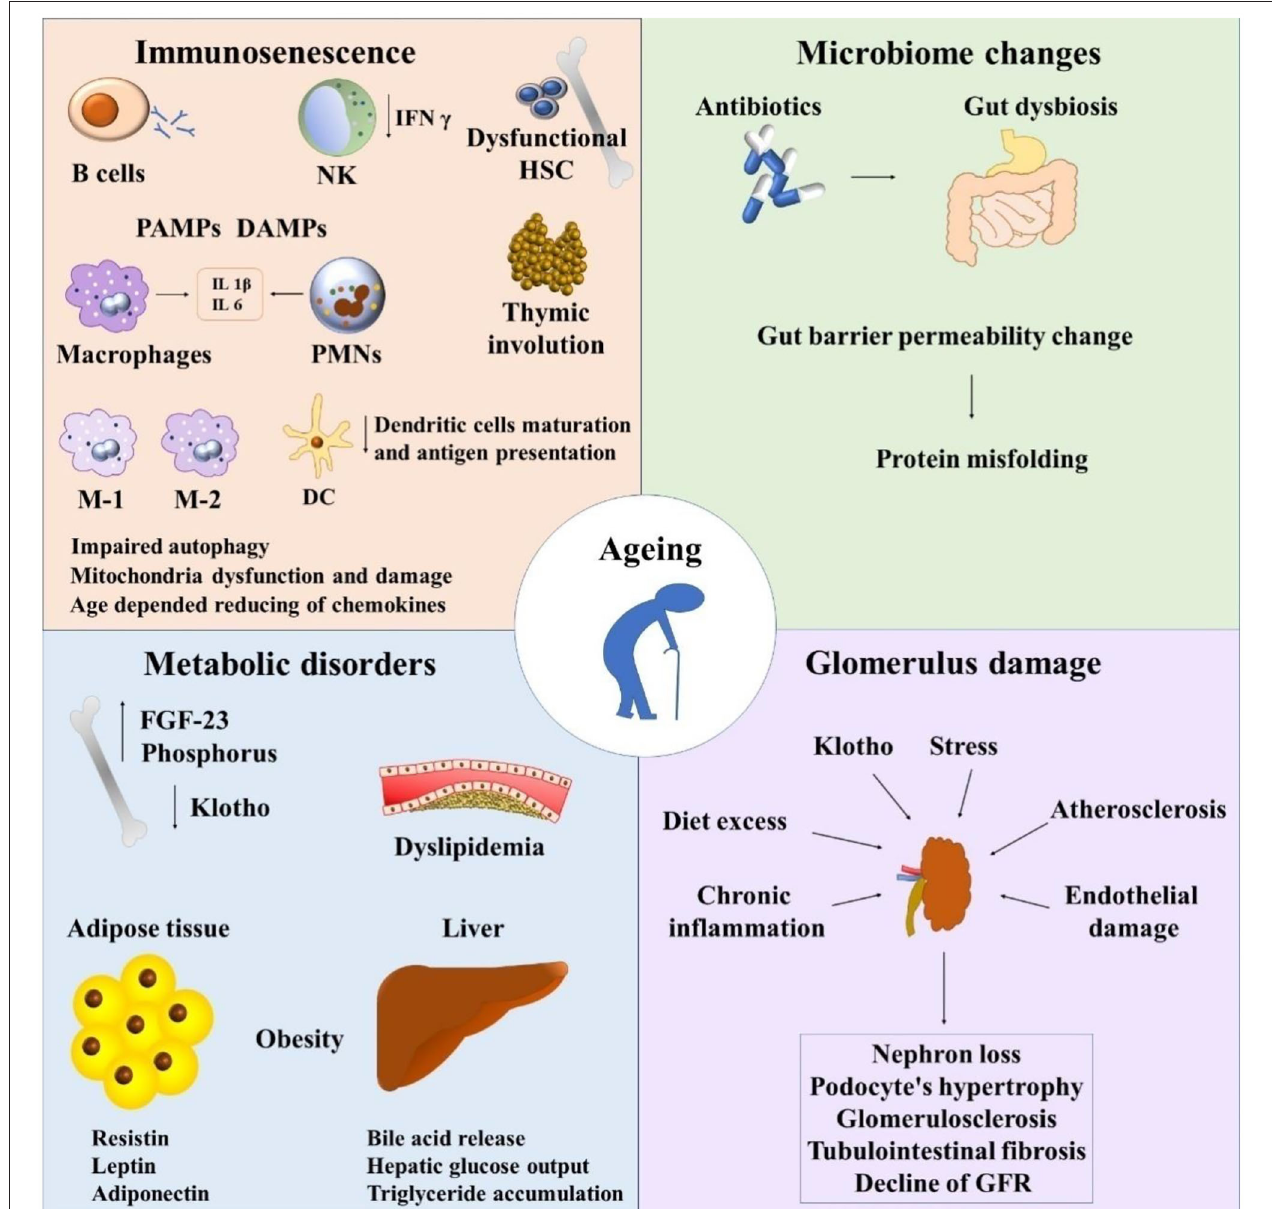
FIGURE 1 | Immunosenescence and chronic kidney disease. NK, natural killers; HSC, hematopoietic stem cells; PAMPs, pathogen-associated molecular pattern molecules; DAMPs, damage-associated molecular pattern molecules; PMNs, polymorphonuclear leukocytes; FGF-23, fibroblast growth factor 23; GFR, glomerular filtration